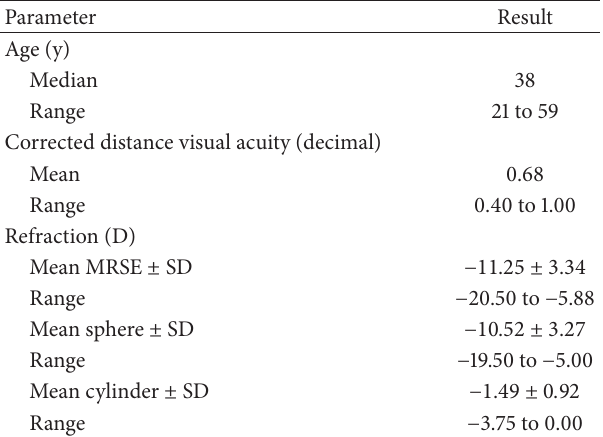
Table 1: Patient demographics and preoperative